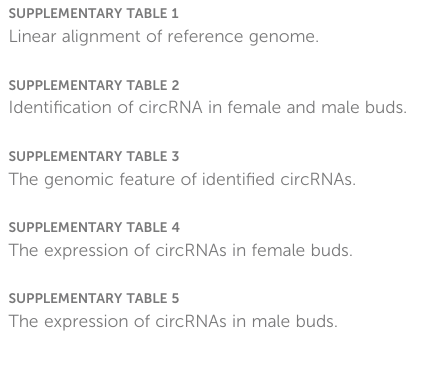
SUPPLEMENTARY TABLE 4 The expression of circRNAs in female buds. SUPPLEMENTARY TABLE 5 The expression of circRNAs in male